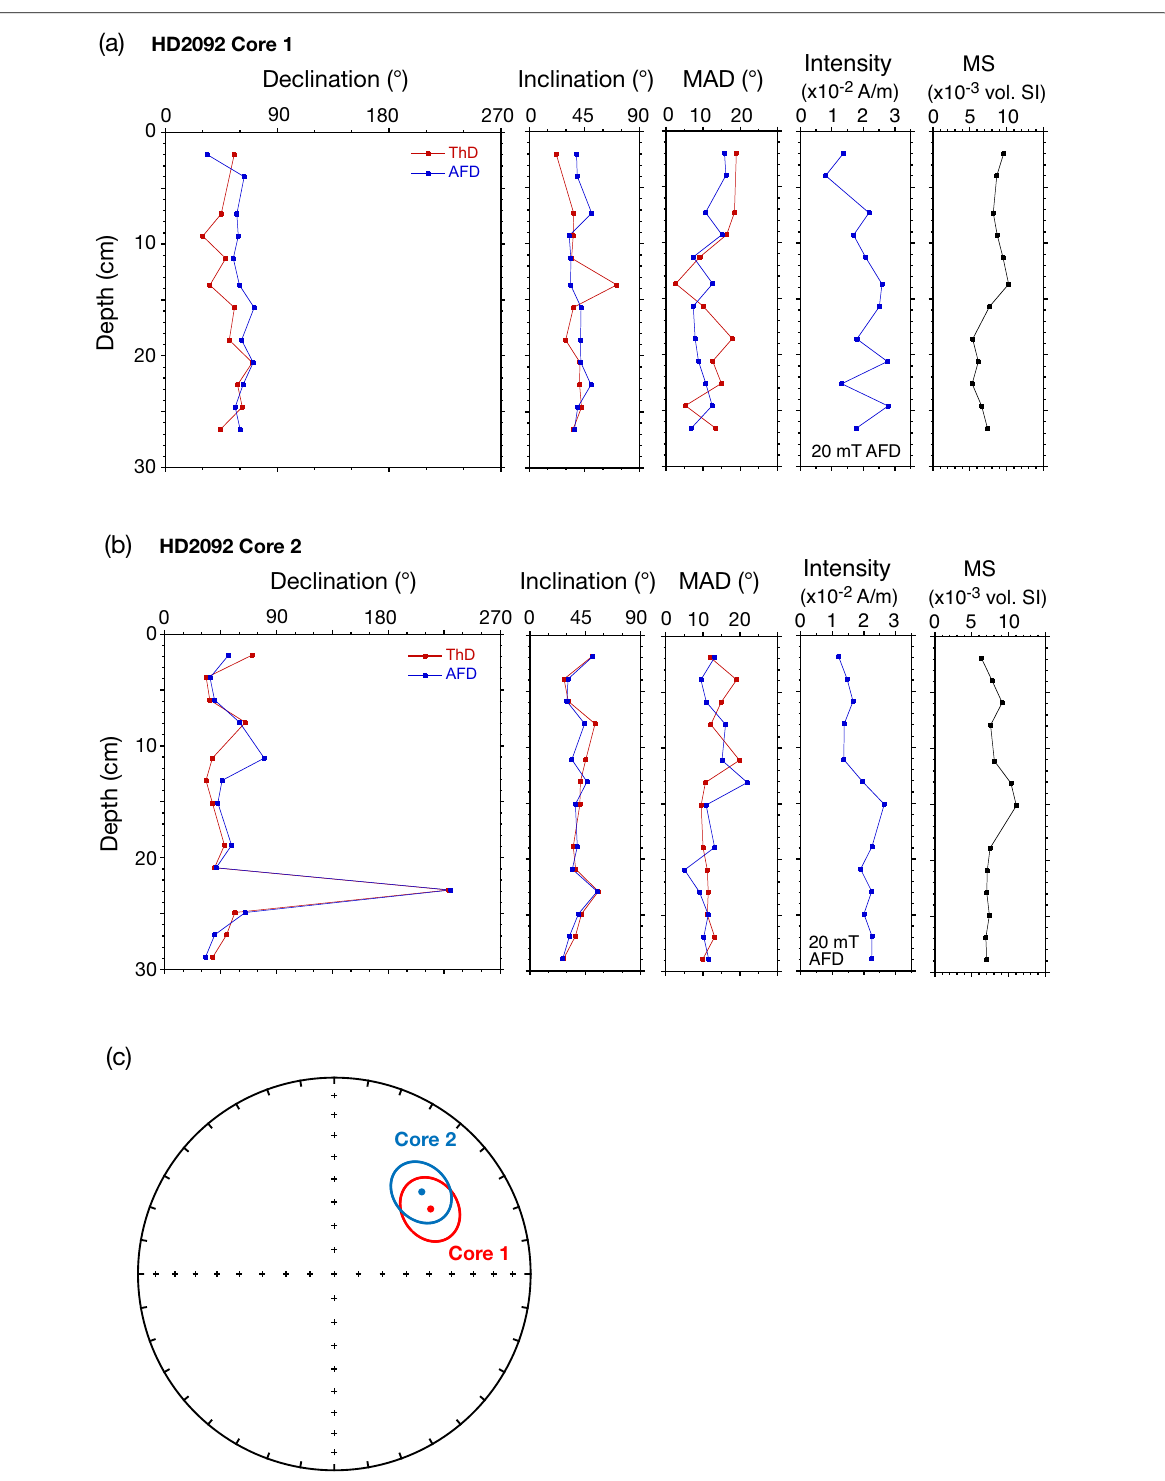
Fig. 4 Results of paleomagnetic measurements. From left to right, declination, inclination, maximum angular dispersion (MAD), intensity of natural remanent magnetization before demagnetization, and magnetic susceptibility (MS) with depth of Core 1 ( a ) and Core 2 ( b ) collected during the Dive 2092 of the ROV Hyper-dolphin after stepwise thermal (red) and AF (blue) demagnetization. c The mean paleomagnetic directions and the 95% confidences of Cores 1 (red) and 2